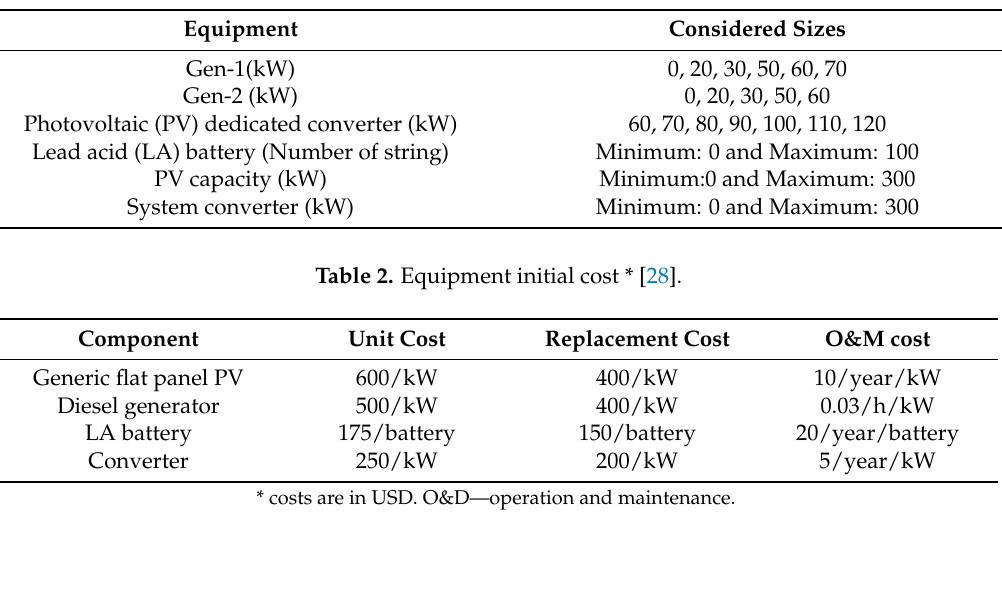
Table 1. Sizes for optimisation of different equipment.